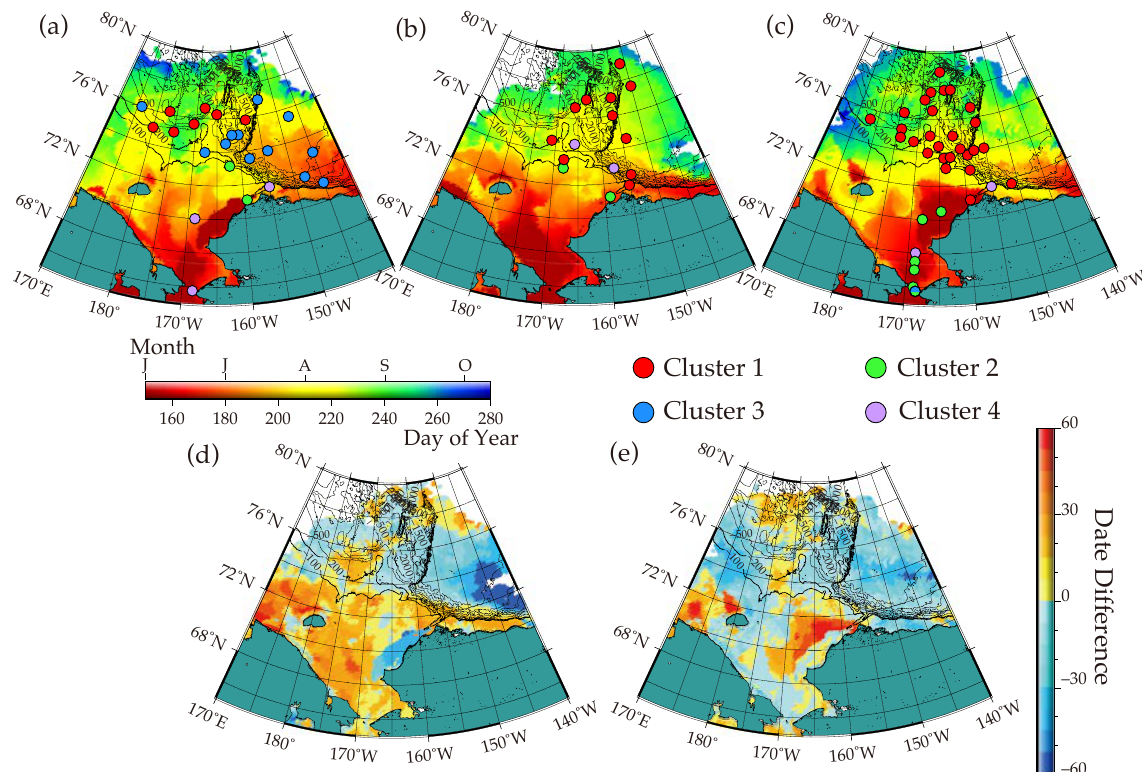
Fig. 7. Distribution of the clusters across Julian day when the area became open water in (a) 2008, (b) 2009 and (c) 2010. Clusters were identified by cluster analysis. White indicates areas where no open water appeared during the entire year. Differences of sea ice retreat timing between (d) 2008 and 2009, and between (e) 2008 and 2010 were also calculated subtracting Fig. 7b and c from Fig. 7a. Depth contours indicate 100-, 200-, 500-, 1000-, 1500-, and 2000-m intervals,